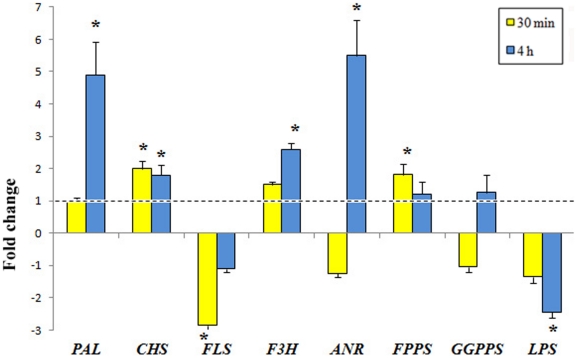
Time-course quantitative gene expression of some G. biloba genes involved in phenylpropanoid and terpenoid metabolism upon herbivory.Phenylalanine ammonia lyase (PAL) and anthocyanidin reductase (ANR) were significantly up regulated by herbivory only after 4 h, whereas flavonol synthase (FLS) was down-regulated at 30 min and 4 h. Chalcone synthase (CHS) showed a constant up-regulation, whereas flavanone 3-hydroxylase (F3H) showed an increased up regulation after 4 h. Farnesyl diphosphate synthase (FPPS) was significantly upregulated only after 30 min whereas geranylgeranyl diphosphate synthase (GGPP) showed no regulation at all times. Levopimaradiene synthase (PPS) was significantly down-regulated at all times. The dotted lines represent control values (mechanical damage), different letters indicate significant (P<0.05) differences, asterisks indicate significant (P<0.05) differences with respect to control.